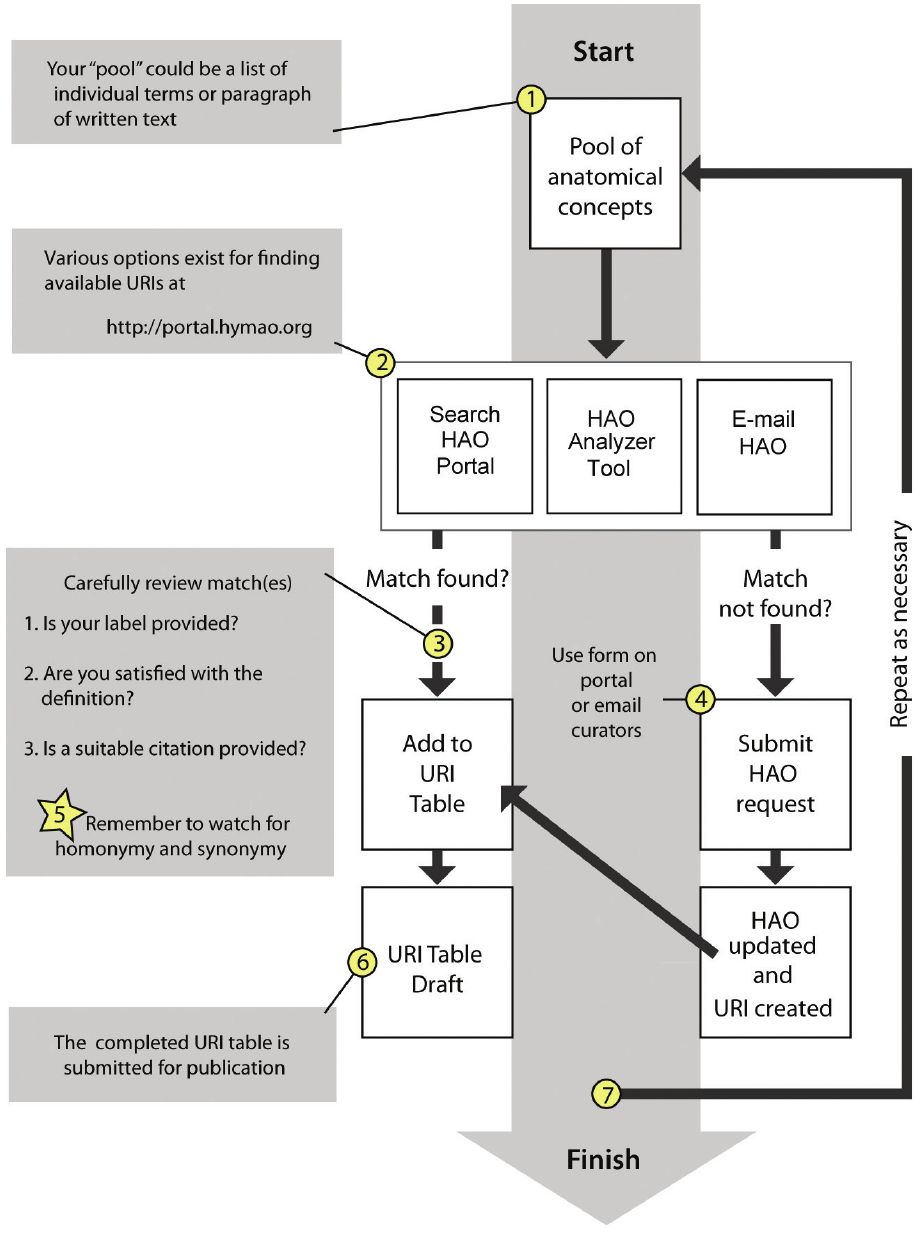
Figure 1. Workflow for drafting a URI table. 1. Provide your text: Copy and paste your text, or type directly into the text box (Fig. 2B). Try to limit the text in the box to that which is pertinent to the underlying ontology being analyzed (e.g., do not include specimen examined sections